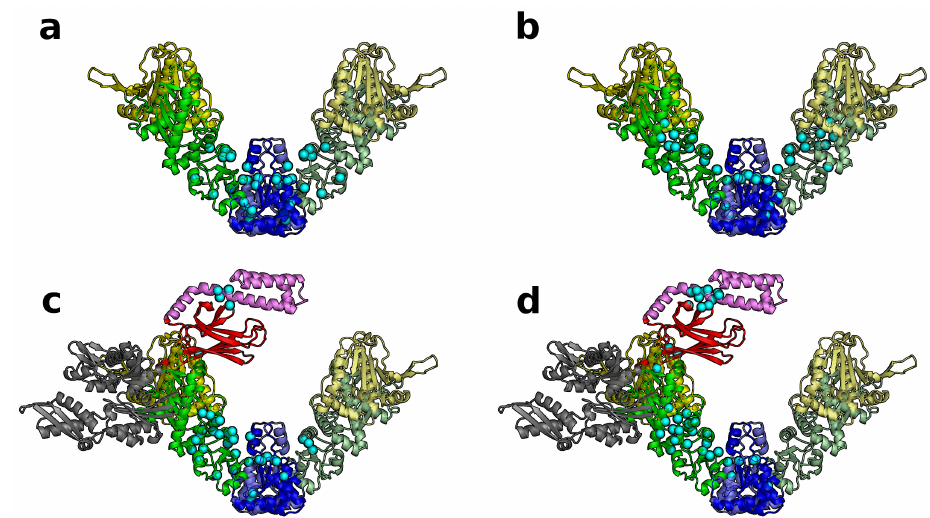
Figure 8. Hot-spot residues for the Hsp90 Ec and asymmetric Hsp90 Ec -DnaK models. The top 2% (38) residues were mapped on the structures as cyan beads to indicate the amino acids involved in the allosteric wiring diagrams for each mode. ( a , b ) unbound Hsp90 Ec modes 7 and 8 ( c , d ) asymmetric Hsp90 Ec -DnaK modes 8 and 10, respectively. All two-dimensional graphs in this paper including displacement graphs and correlation matrices were made using Python [122] and MatPlotLib [123]. Three-dimensional protein models were made with both PyMol [124] and VMD [125]. Raster images were edited using GIMP [126] and vector images were edited using Inkscape